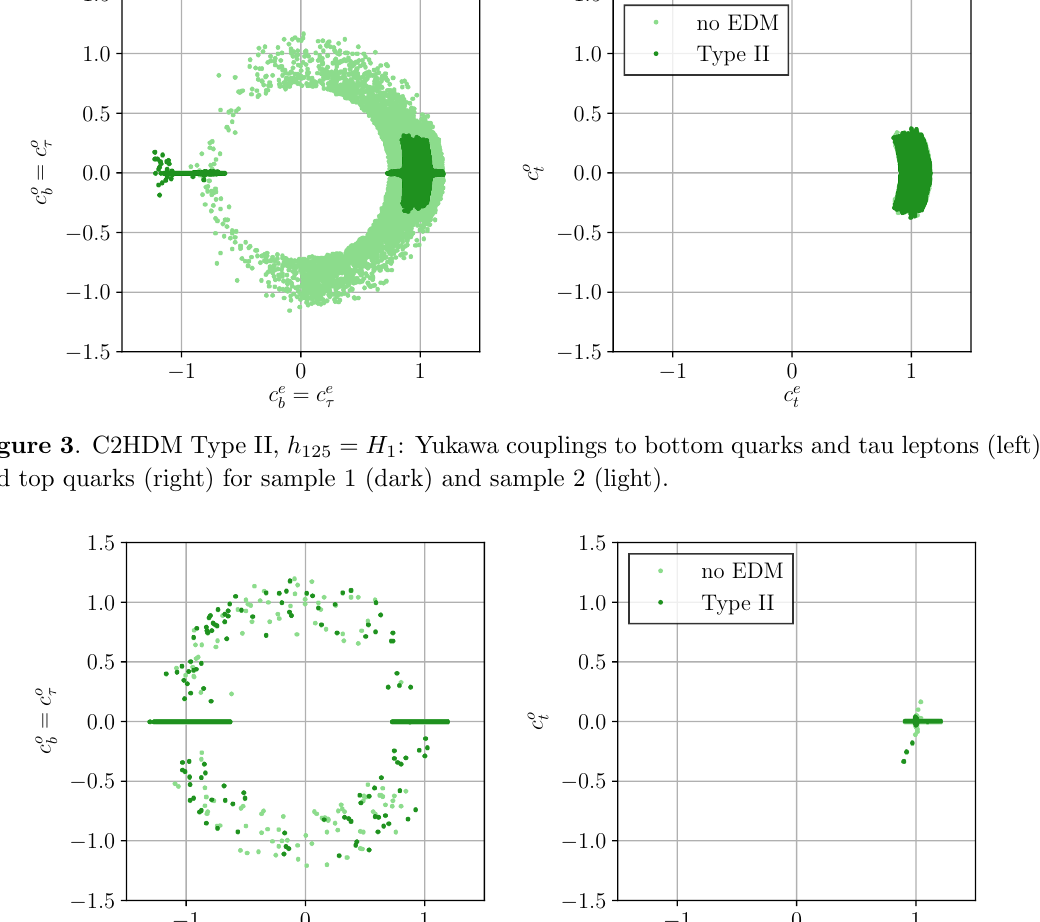
= H : Yukawa couplings to bottom quarks (left) and top quarks 125 2